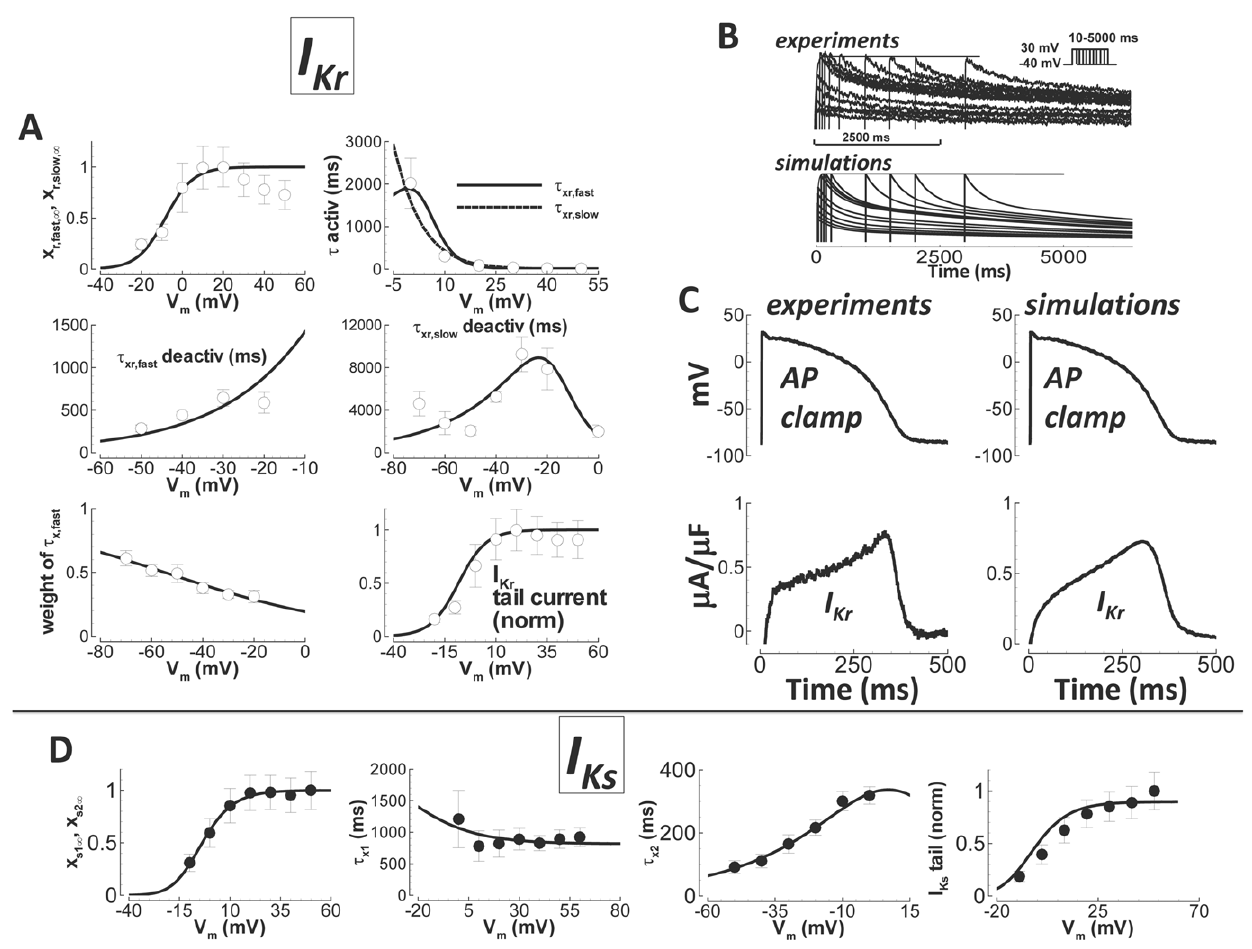
Figure 3. Undiseased human I Kr and I Ks experiments and model validation. A) I Kr . Experimental data are white circles (N=10 from 7 hearts for steady state activation, N=7 from 3 hearts for activation and from 2 hearts for deactivation time constants and weights, and N=10 from 7 hearts for tail currents). Simulation results are lines. From left to right, top to bottom: steady state activation, time constant for activation (fast (solid) and slow (dashed) time constants converge), fast time constant for deactivation, slow time constant for deactivation, relative weight of the fast component for deactivation, and the I–V curve for normalized tail currents. B) Activation/deactivation profiles in response to the voltage steps shown ( 2 40 mV holding potential to + 30 mV steps of various duration, followed by a return to 2 40 mV, top right inset). Experiments are above. Simulations are below. Activation is rapid, occurring within tens of milliseconds. Deactivation is slow, occurring after several seconds. C) Human AP clamp waveform (top), used to elicit 1 m M E-4031 sensitive current (I Kr , bottom); experiments are on the left, and comparison to simulations using the same AP clamp is on the right. D) I Ks . Data are from Vira´g et al.[41] (black circles). Simulation results are solid lines. From left to right: steady state activation, time constant for activation (much slower than deactivation at depolarized potentials), time constant for deactivation (much faster than activation at hyperpolarized potentials), and the I–V curve, showing normalized tail currents.